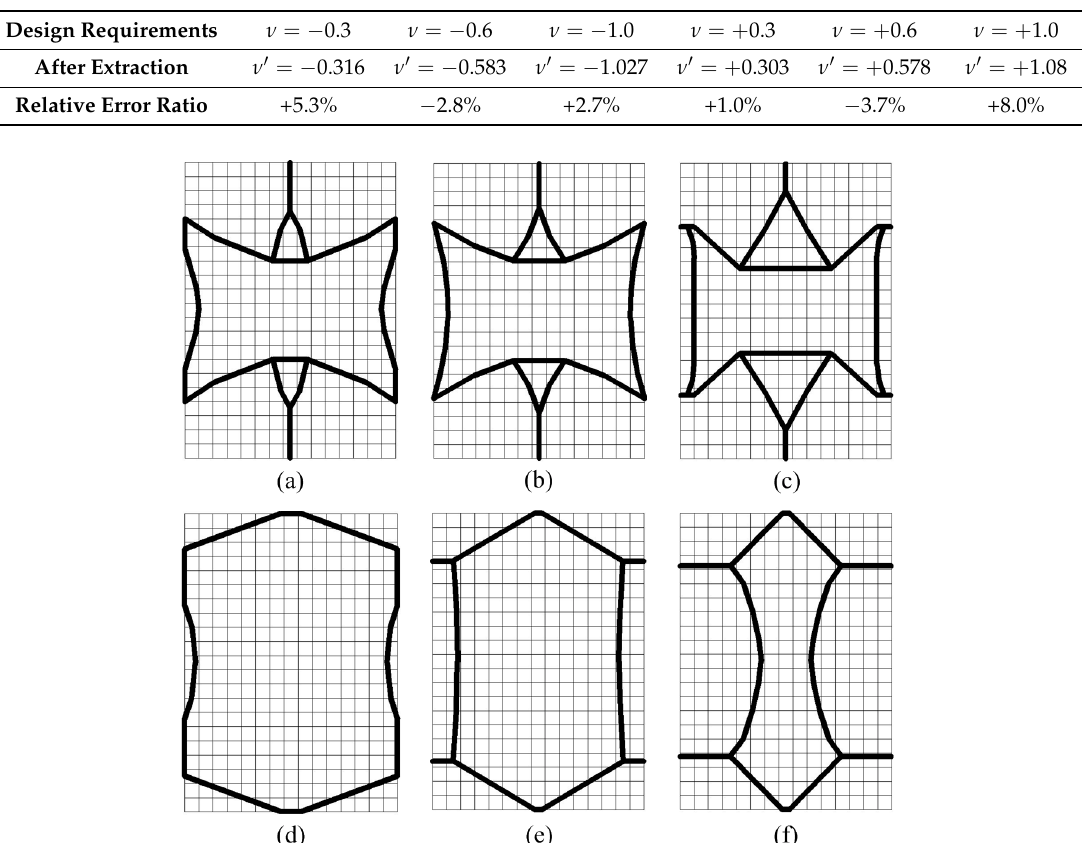
Table 1. Relative errors of Poisson’s ratio between the extracted configurations and design requirements ( 𝜈 = 𝜈 (cid:3027)(cid:3025) = 𝑃𝑅𝑍𝑋 ).